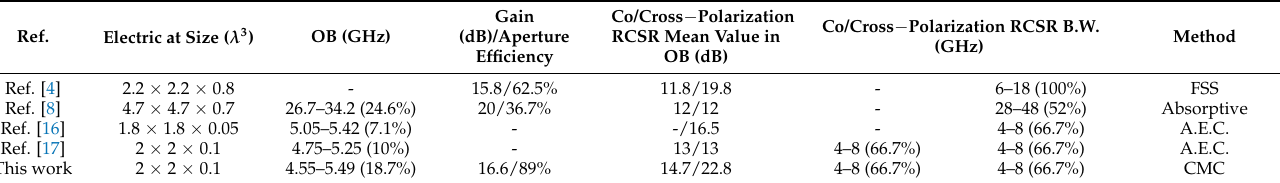
Table 2. Comparison with typical low-RCS